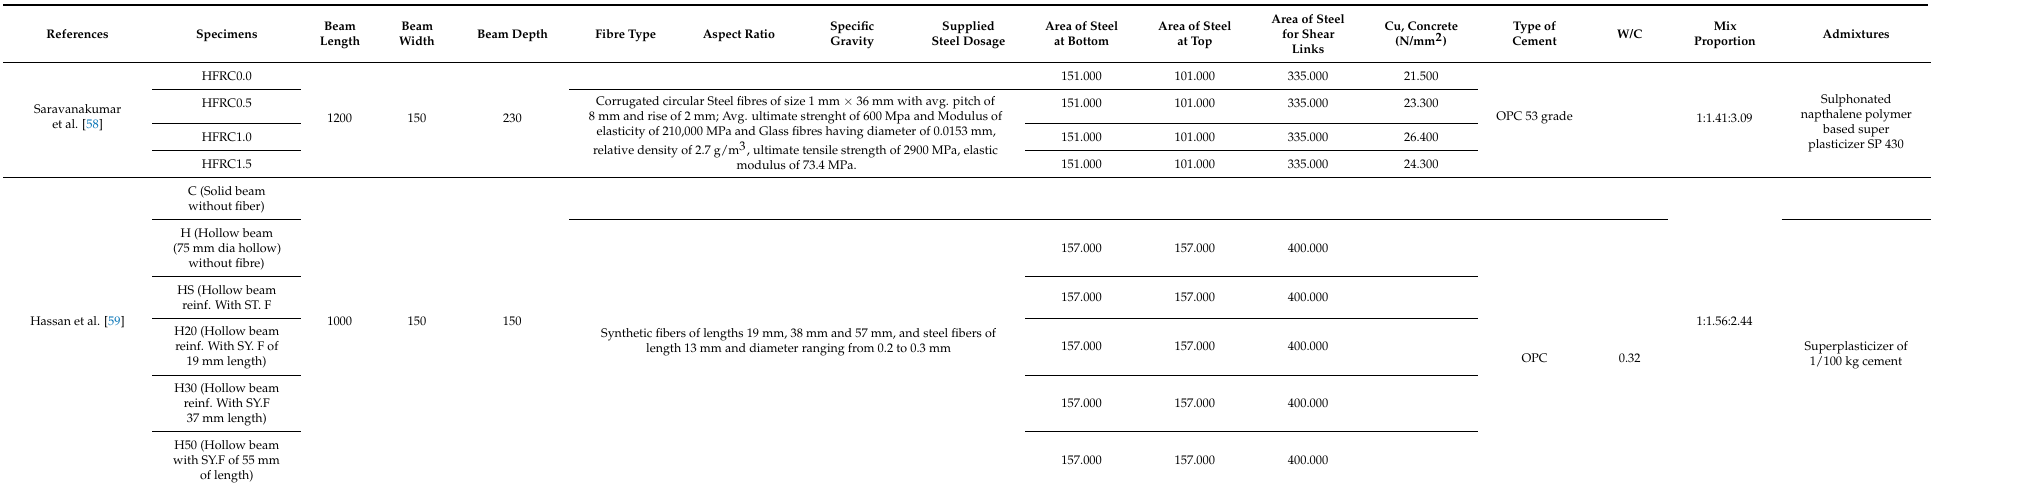
Table 3. Methods of preparation of hybrid fibre reinforced concrete from previous